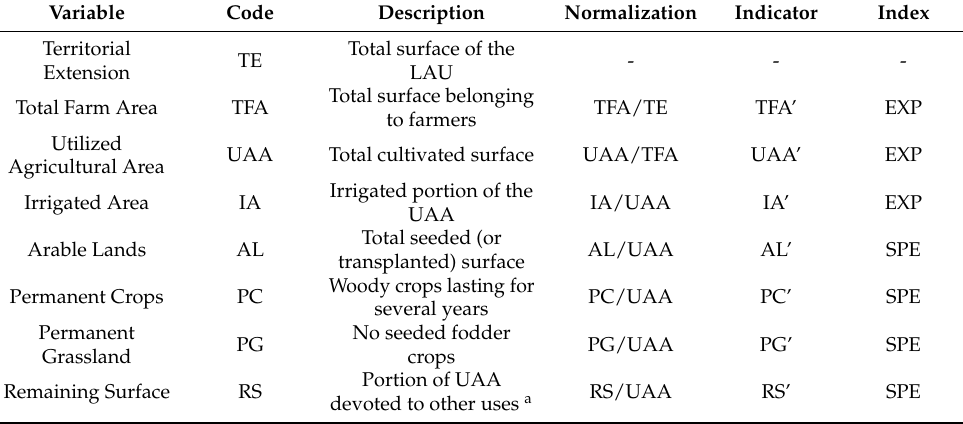
Table 2. The considered variables (name, code and description), the normalization method used to generate the corresponding indicators and the index to which they